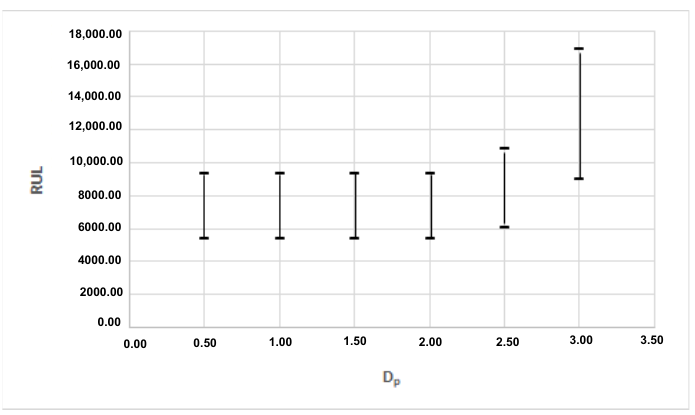
Figure 23. Variations of [ RUL lim